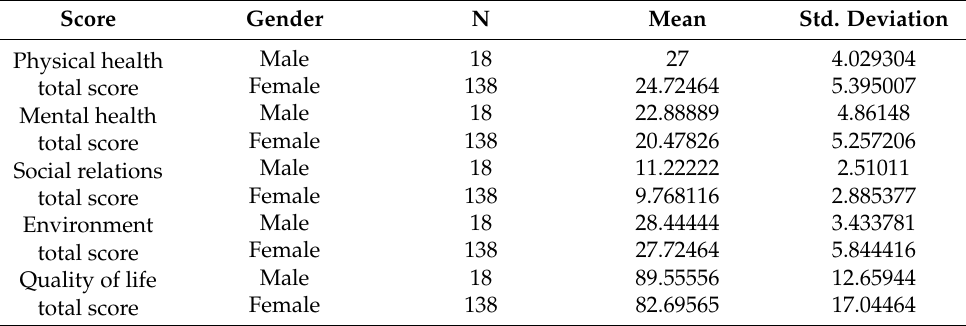
Table 2. Correlations between the WHOQOL26 mean scores and